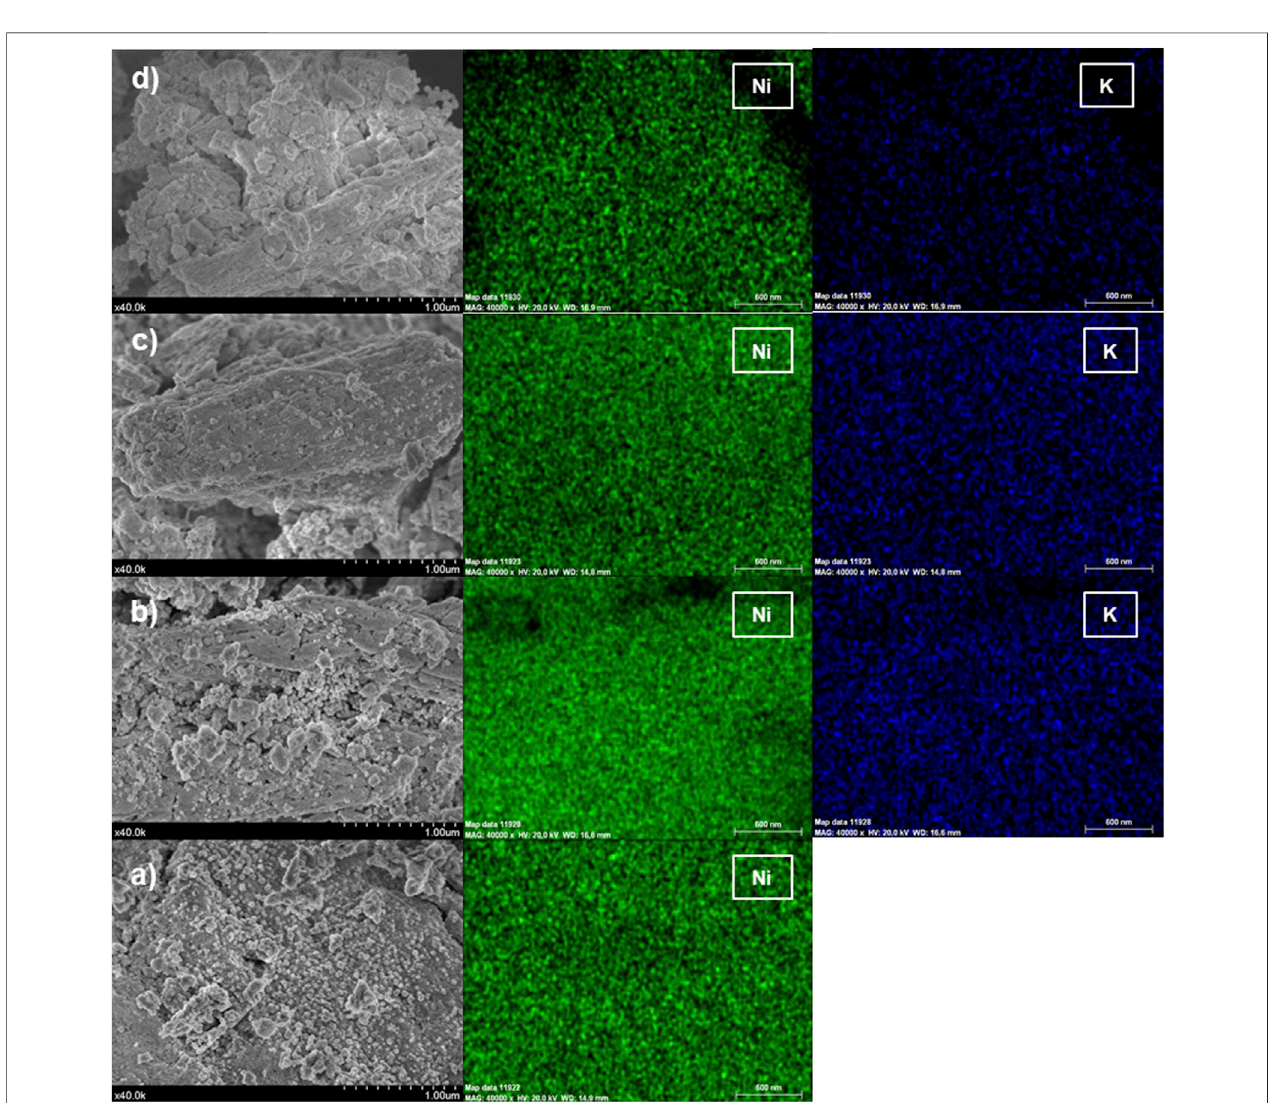
FIGURE 3 | SEM images of the (A) 0K, (B) 0.5K, (C) 1K, and (D) 2K catalysts.